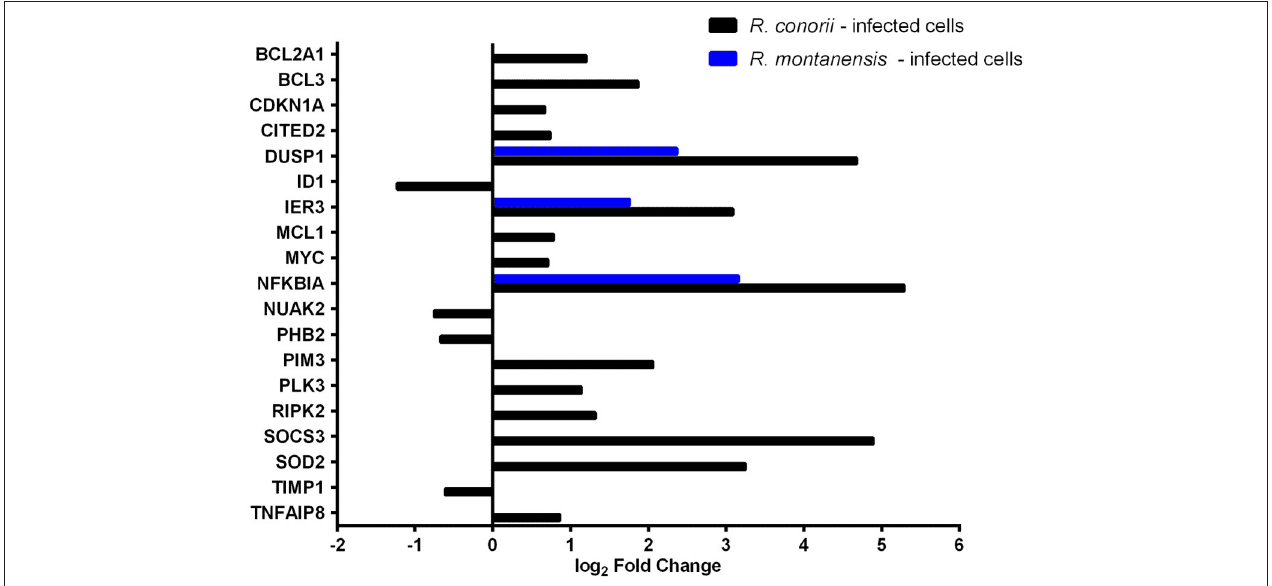
FIGURE 5 | Rickettsia species differentially modulate the expression of several host apoptotic genes early in infection of THP-1 macrophages. Log 2 fold change values of DE genes categorized with GO term “negative regulation of apoptotic process” (GO:0043066) in R. conorii - (black) and R. montanensis -infected (blue) cells. Absence of bar means that the fold change of that gene for the respective experimental condition was not considered statistically significant. See also Table S9